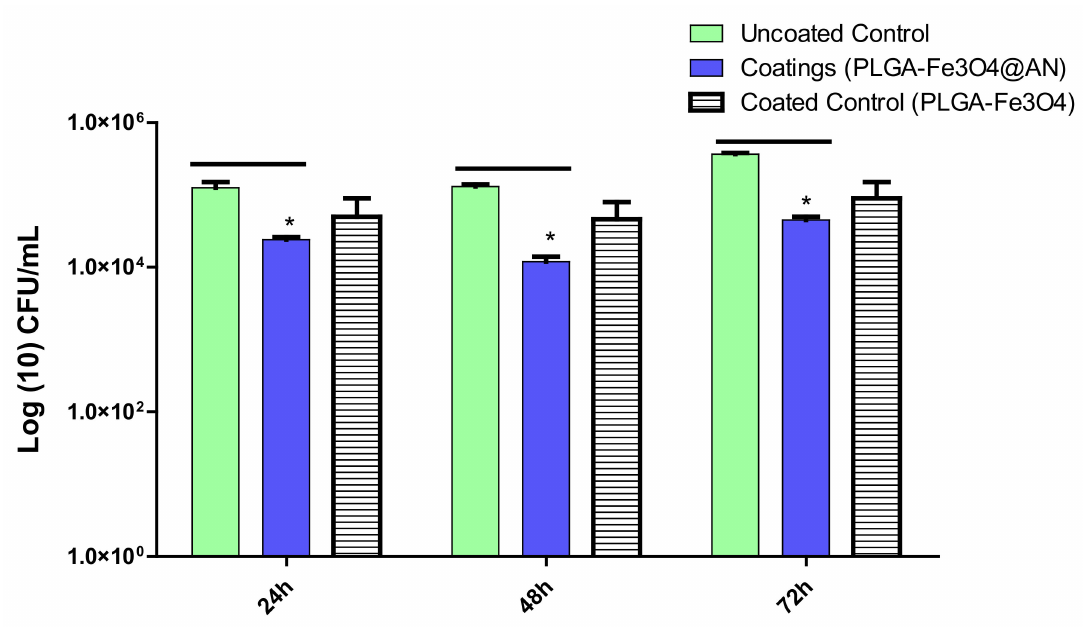
Figure 9. C. albicans biofilm formation (expressed as CFU (colony-forming units) / mL values) on control and coated surfaces for 24, 48, and 72 h of incubation at 37 ◦ C (* p ≤ 0.05; comparison of coating versus control sample for the same time